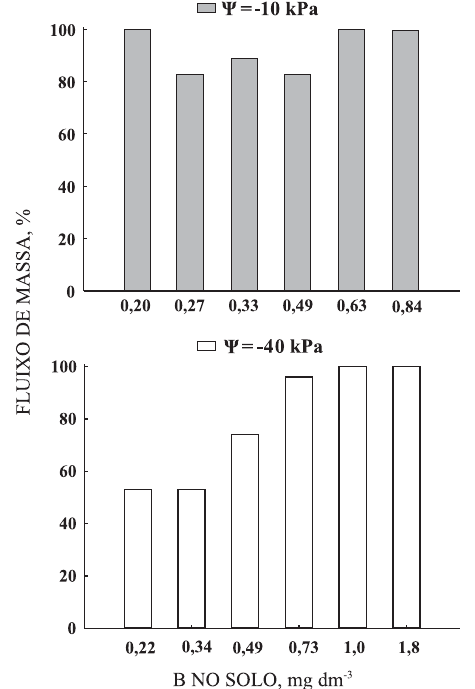
Figura 5. Percentual de B potencialmente trans- portado por fluxo de massa em resposta ao B extraído do solo (B solo), considerando o poten- cial de água do solo ( ΨΨΨΨΨ ).